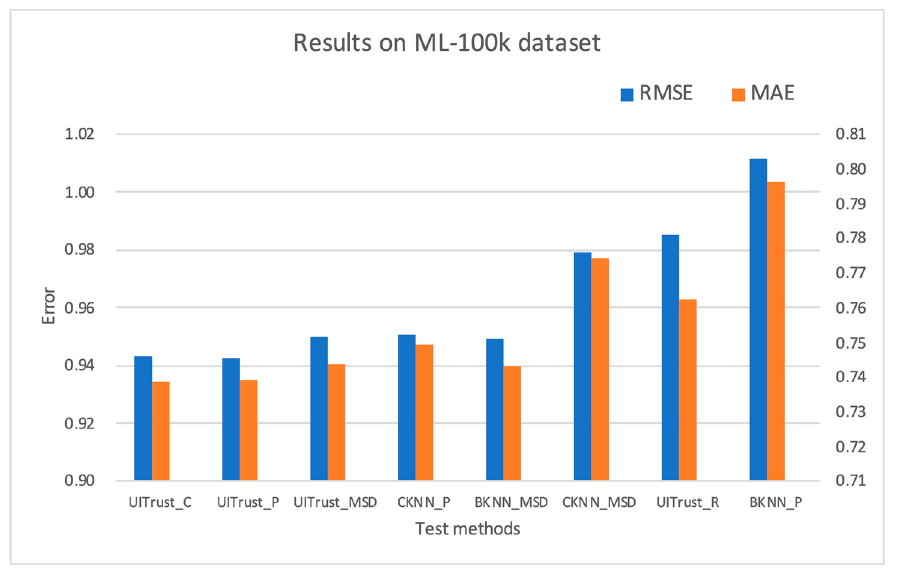
Figure 2. Prediction accuracy obtained using different methods for the ML-100k dataset. MAE—mean absolute error, RMSE—root mean square error.